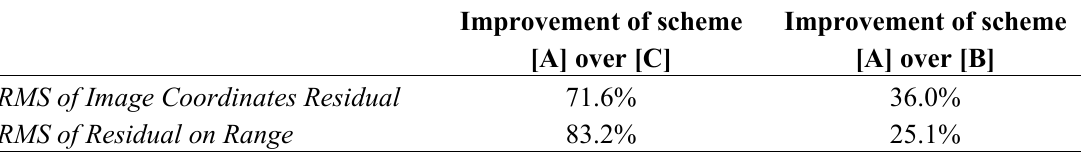
Table 6. Improvements achieved by the proposed calibration method.